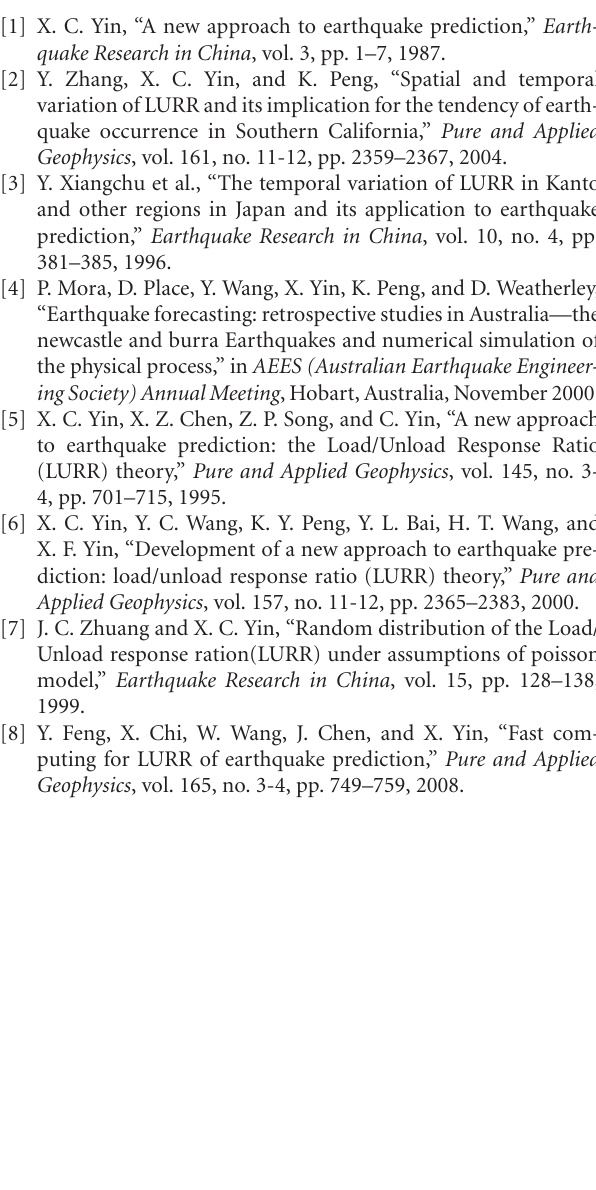
Figure 2: Speedup.